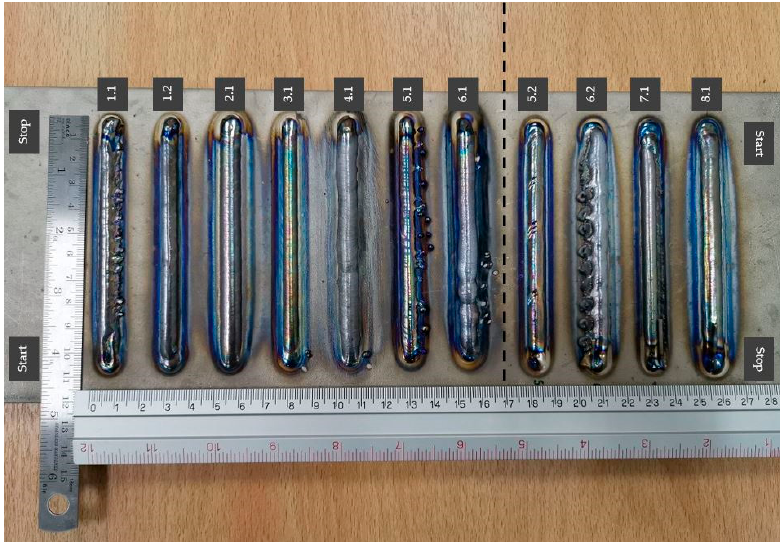
Figure 2. Deposited single beads for a designed experiment for the hot-wire plasma welding process (Numbers 1–8).